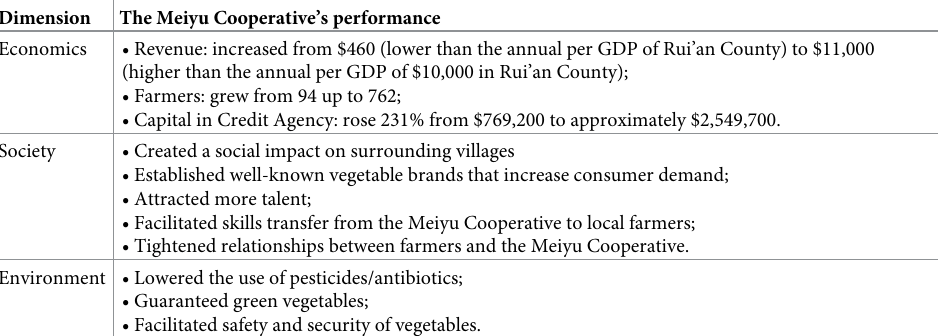
Table 1. The Meiyu Cooperative’s economic, social, and environmental performance since supply chain